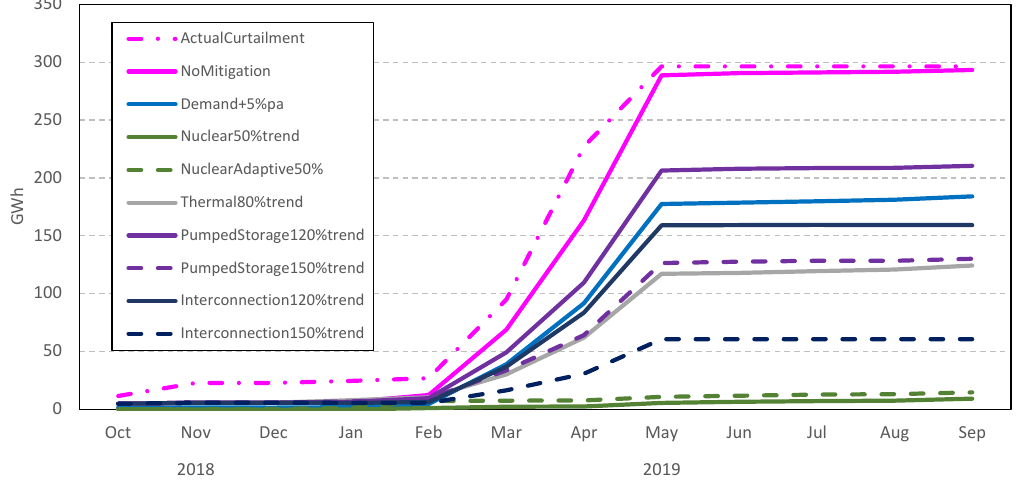
Figure 11. Cumulative sum of actual curtailment and forecast scenarios that reduced curtailment from October 2018 to September 2019.